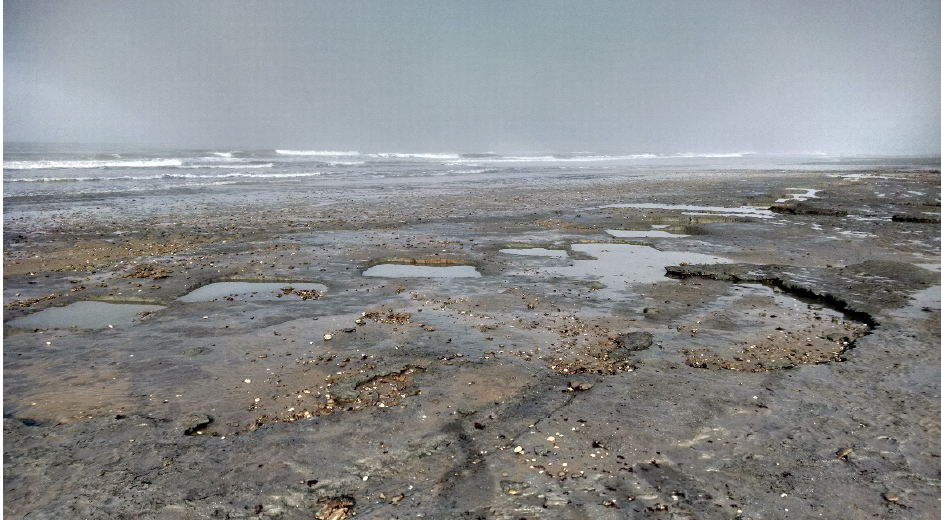
Figure 4. Impermeable peat layer that outcropped along the foreshore after March 2018 storm.